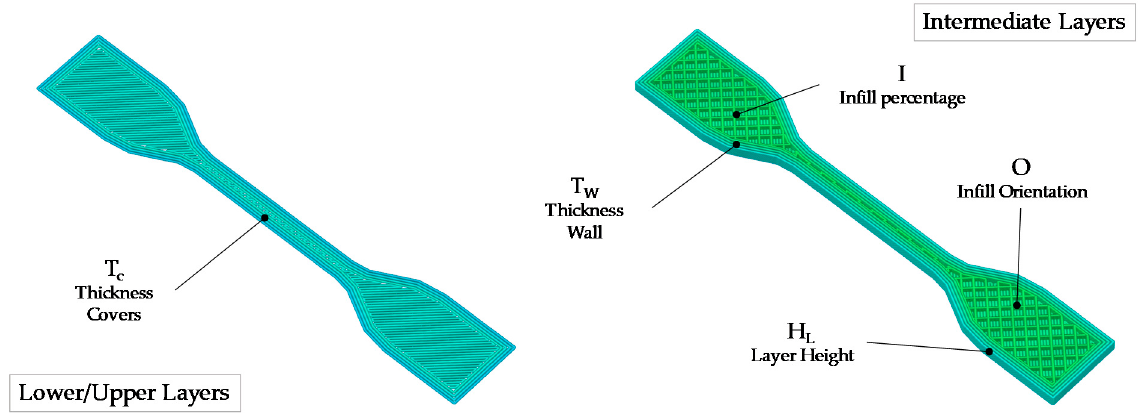
Figure 3. Inner-design factors in MEX ( T C : thickness of covers, T w : thickness of the wall, I : infill percentage, H L : layer height, O : infill orientation).